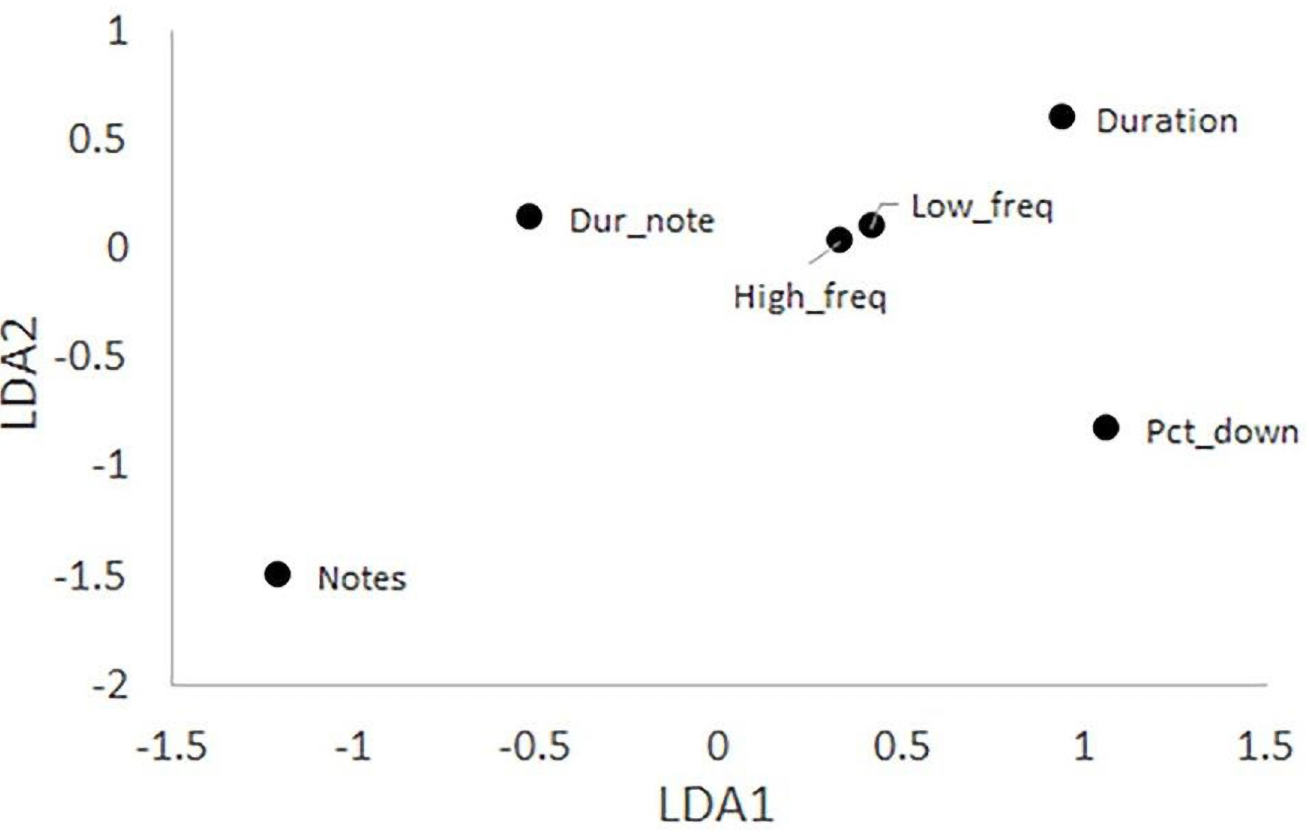
Fig 2. Plot showing the scaling coefficients of the Linear Discriminant Analysis of Louisiana Waterthrush song types. The six predictors of song type are arranged around the overall scaled mean (0,0) to indicate their relative influences. The six variables plotted are the number of notes (Notes), note sequence duration (Duration), the duration per note (Dur_note), the percent of duration spent singing the downstroke portions of notes (Pct_down), the minimum frequency (Min_freq), and the maximum frequency (Max_freq). Variables farthest from the scaled mean (Notes and Duration) have the greatest